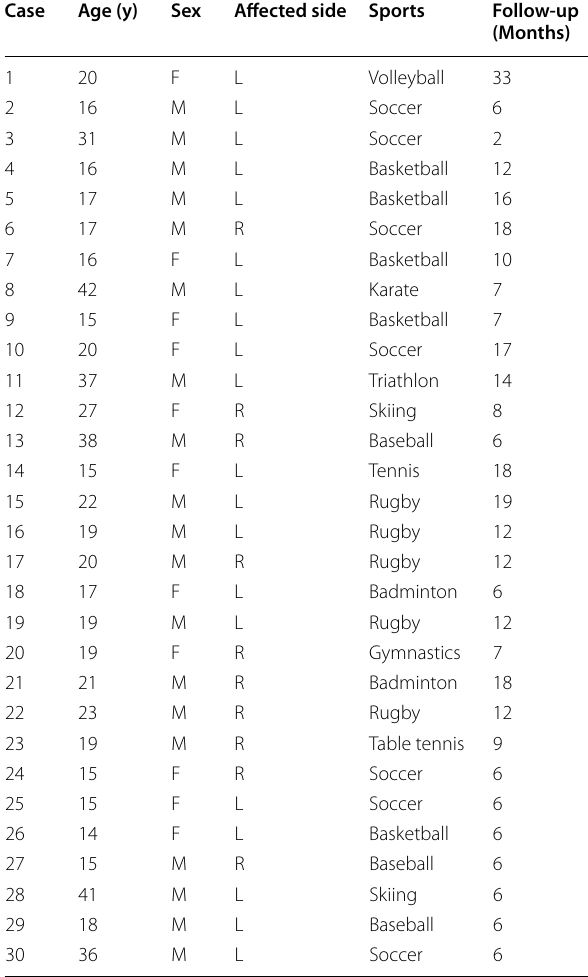
Table 1 Patients’ characteristics